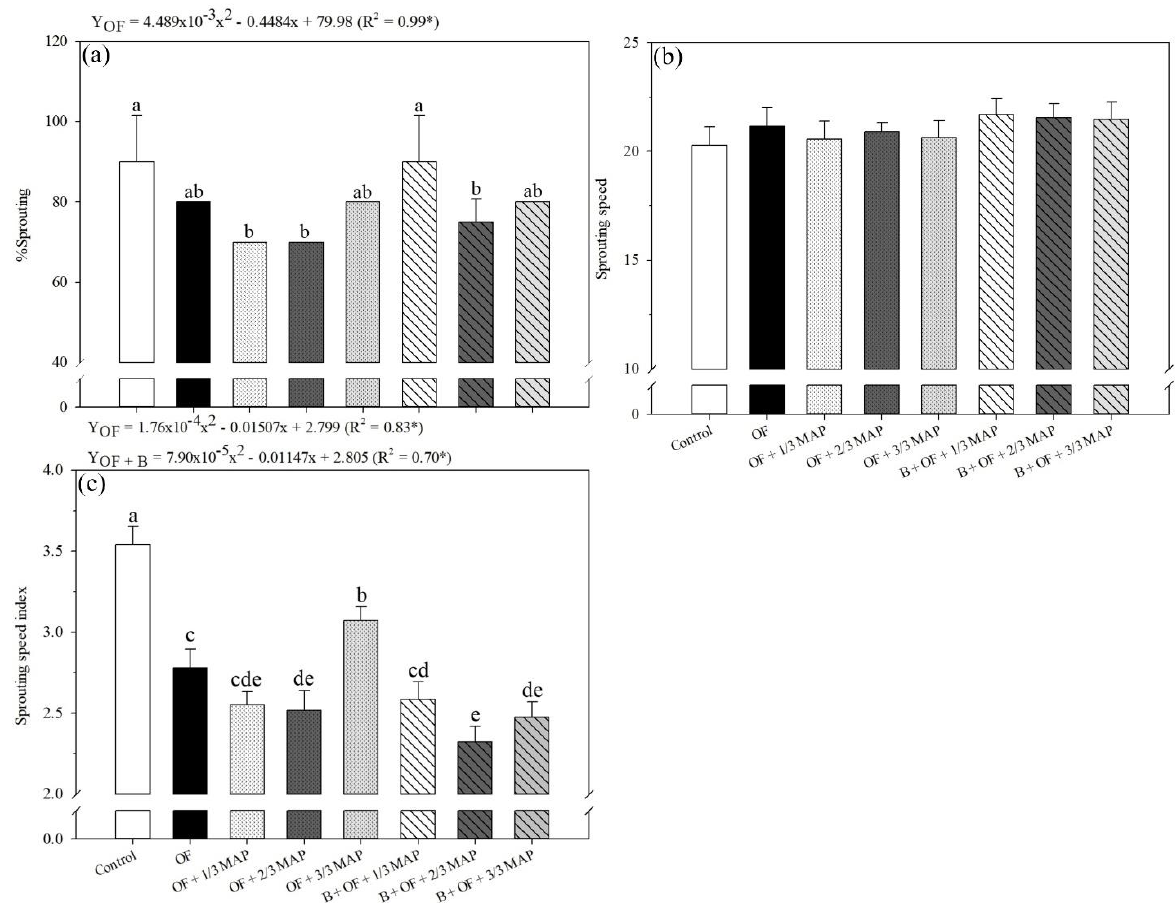
Figure 2. %Sprouting ( a ), sprouting speed ( b ), and sprouting speed index ( c ) of sugarcane seedlings under the association of organomineral fertilizer (OF), B. velezensis (B), and doses of mono ammonium phosphate (MAP). Means followed by the same letter do not differ from each other by the Tukey test at 5% probability. The error bars express the standard deviation of the mean (n = 4). The regression equations and R 2 above the figures include the MAP doses associated with organomineral fertilizer (OF) and with organomineral fertilizer + B. velezensis (OF + B) at the 5% significance level